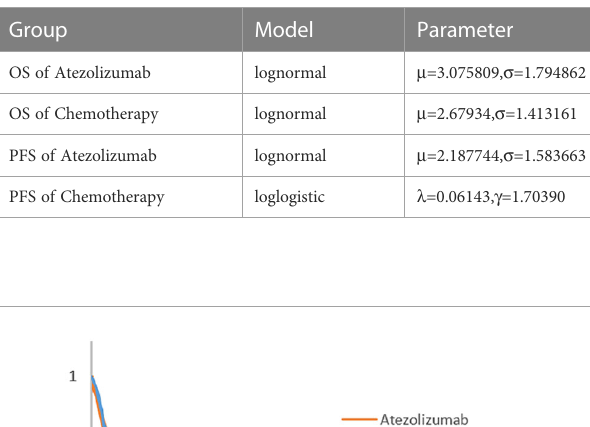
TABLE 1 Survival model parameters fi tting to PFS and